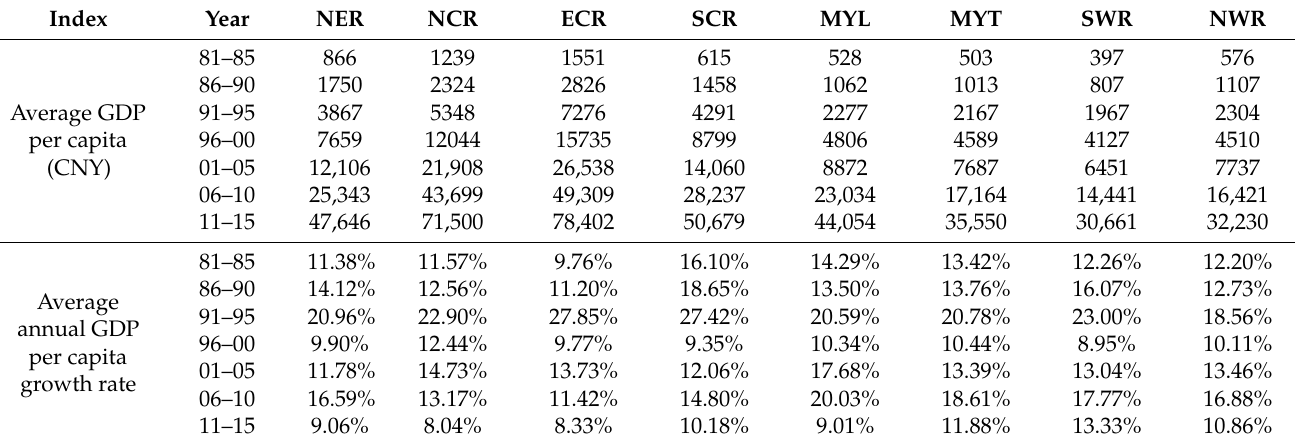
Table 1. Profiles of eight regions of China.